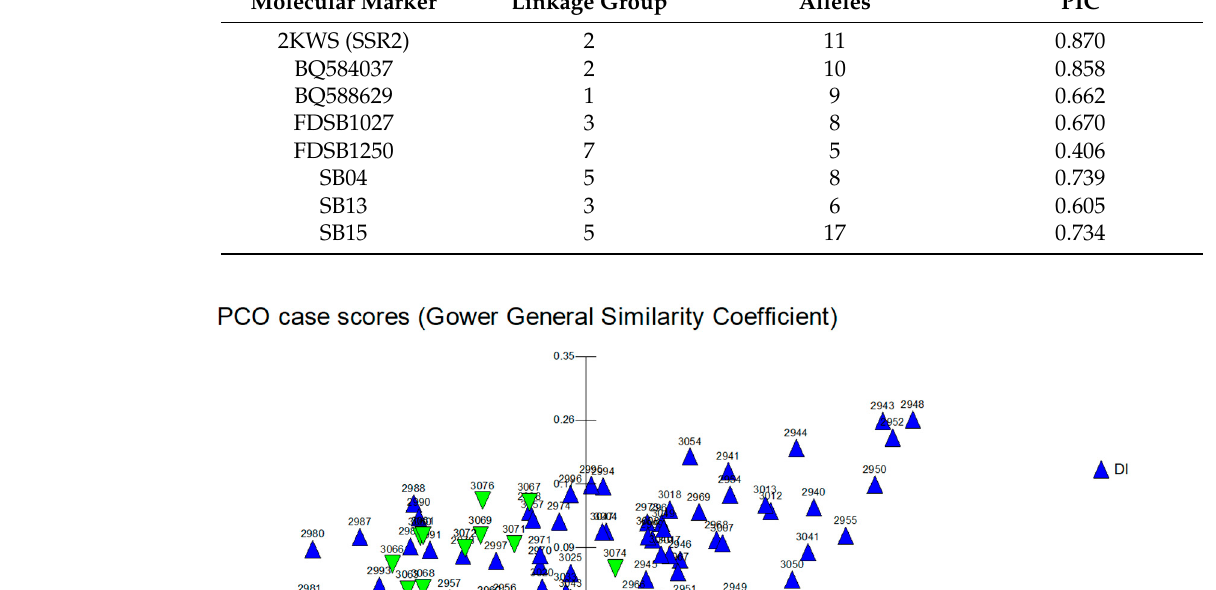
Table 2. SSR markers designations and associated traits. Molecular Marker